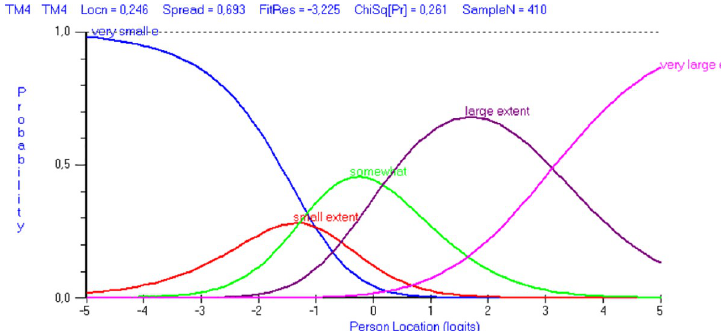
Fig 1. Category probability curves. Category probability curves for item TM4 with response options: To a very small extent, to a small extent, somewhat, to a large extent, to a very large extent.